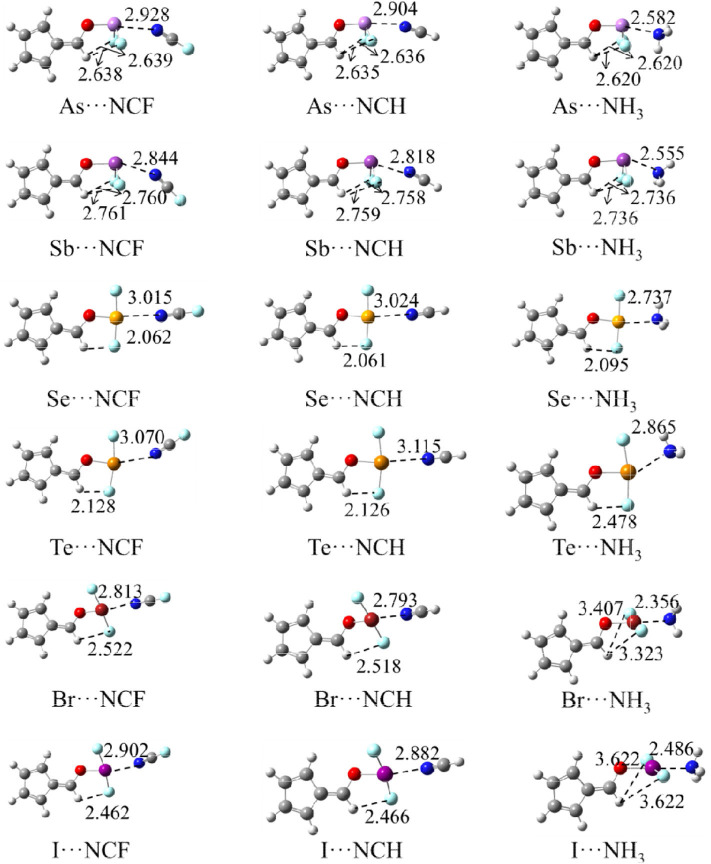
The optimized structures of complexes, distances in Å.